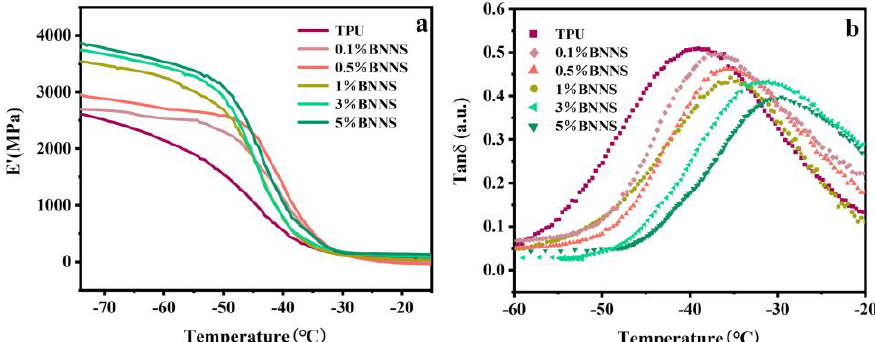
Figure 6. ( a ) Dynamic mechanical analysis storage modulus (E ′ ) and ( b ) loss factor (tan δ) curves of TPU composites.